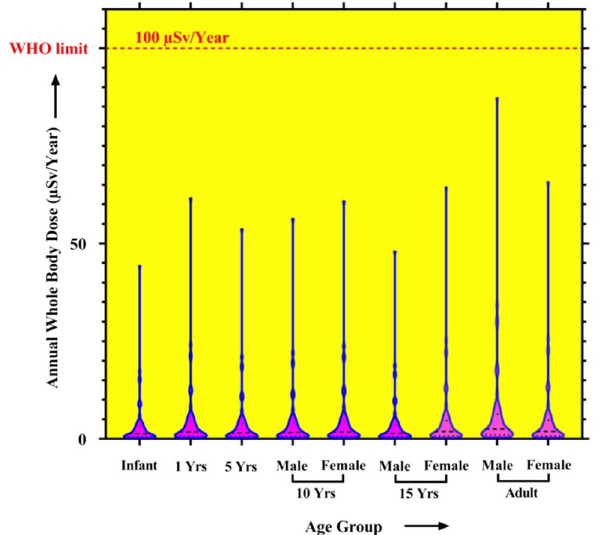
Fig. 20 Violin plot of annual body dose for different age groups